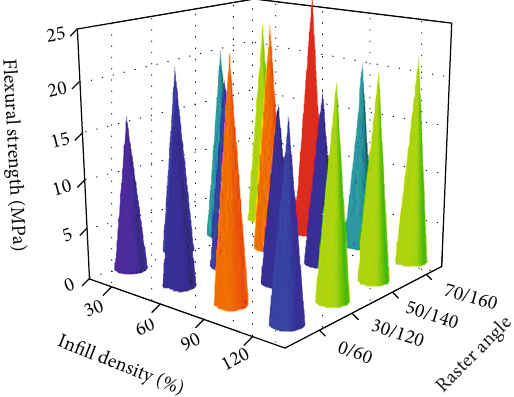
Figure 9: Flexural strength: 3D plot of in fi ll density and raster angle.